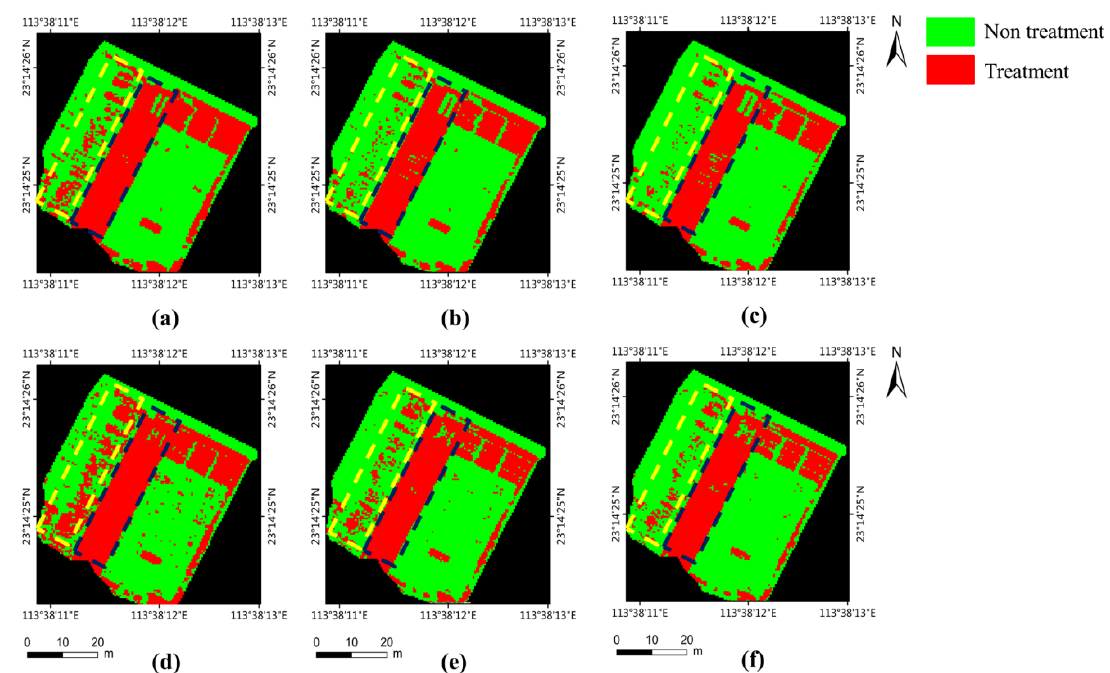
Figure 7. Prescription map generated with different weed thresholds. ( a – c ) Prescription map generated from the GT label using the weed thresholds of 0.0, 0.1 and 0.2. ( d – f ) Prescription map generated from the output weed cover map using the thresholds of 0.0, 0.1 and 0.2. From reference system datum WGS84.